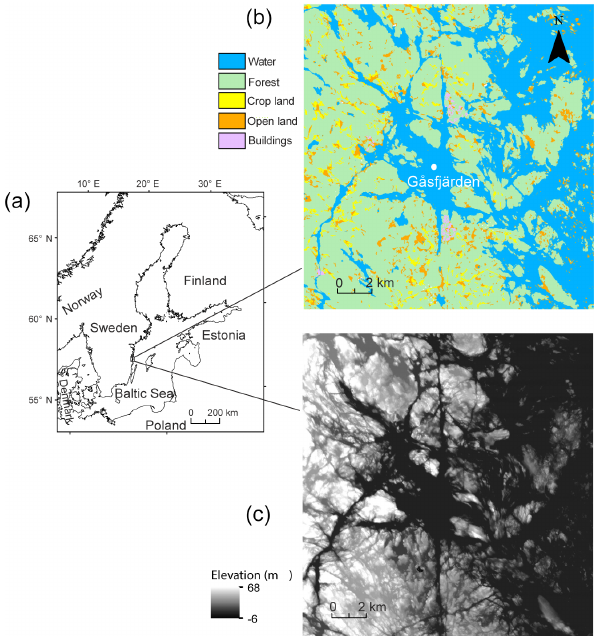
Figure 1. (a) Overview of the Baltic Sea region and the location of Gåsfjärden, (b) the coring site (white circle) and land use map, and (c) the digital elevation model of the study region.